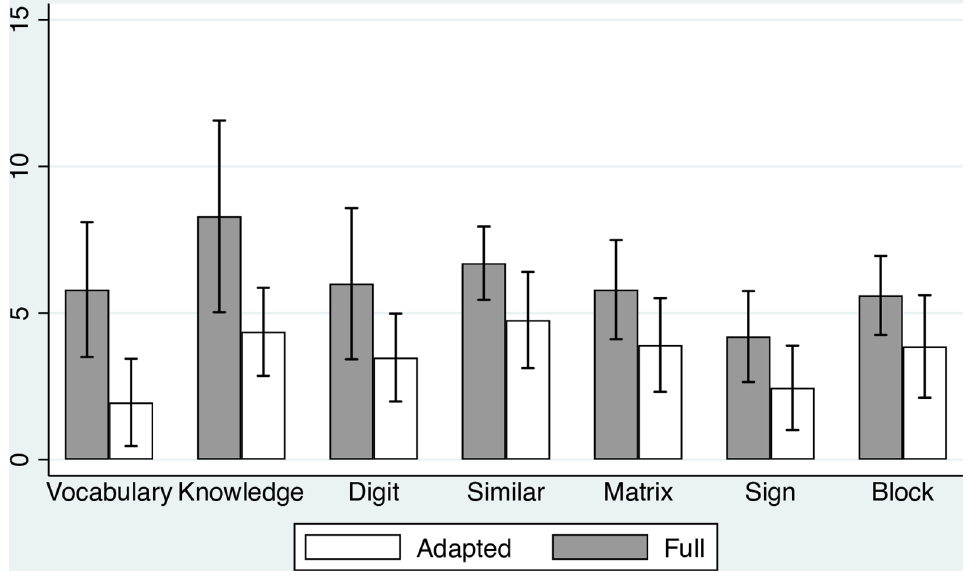
Fig 1. Hierarchy of the verbal and perceptual IQ subscales in the full integration and adapted enrichment groups.